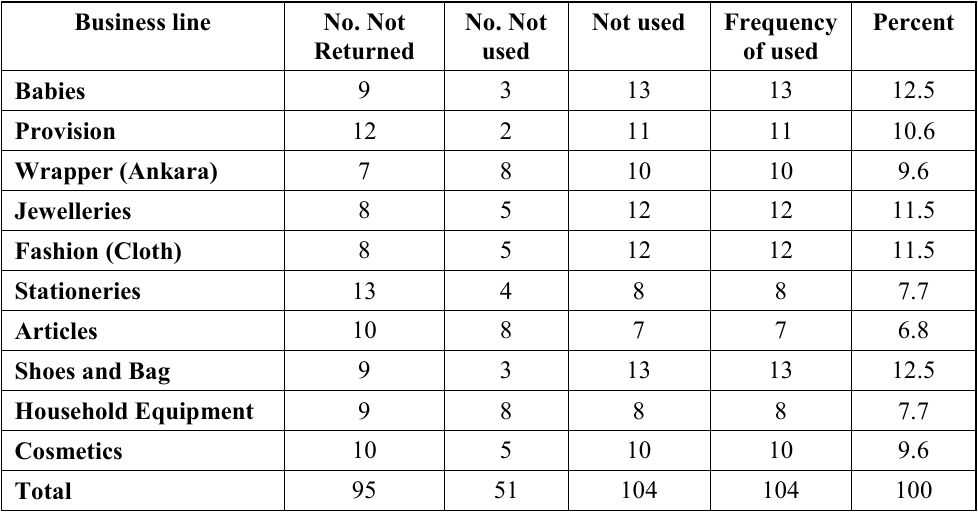
Table 2. Respondents’ Distribution of Questionnaires based on Business